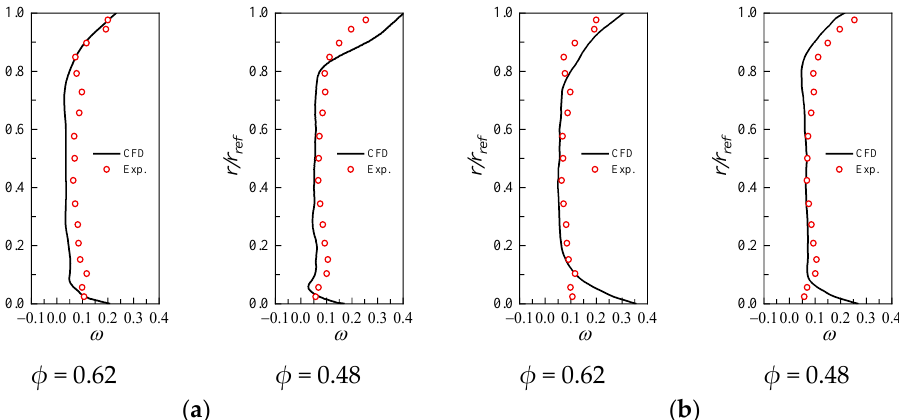
Figure 7. Comparison of rotor and stator loss between the experiment and numerical simulation: ( a ) rotor; ( b ) stator.